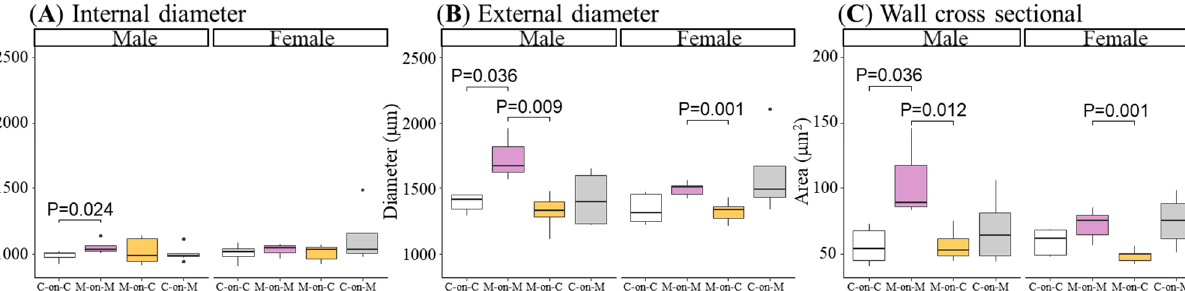
in 21-day-old male and female offspring from MUN and Control mothers. MUN, maternal under- nutrition during gestation; C-on-C, control pups fostered by their mothers (6 males and 6 females); M-on-M, MUN rats fostered by their mothers (6 males and 6 females); C-on-M, control rats fostered by MUN mothers (6 males and 6 females); M-on-C, MUN rats fostered by a control mother (6 males and 6 females). Data show the median and interquartile range [Q1; Q3], and the showed p -Value ( p ) was extracted from Dunnett´s post-hoc pairwise comparison test when the Kruskal-Wallis test was